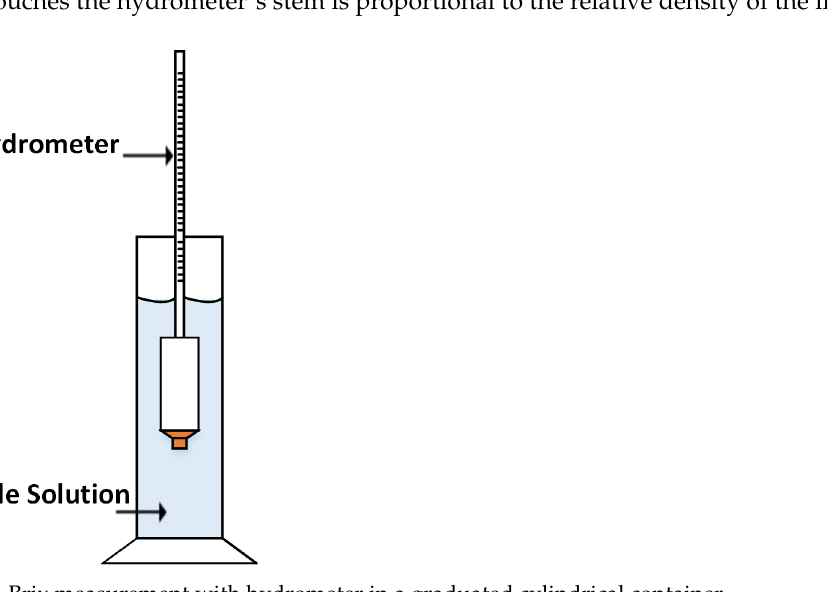
Figure 2. Brix measurement with hydrometer in a graduated cylindrical